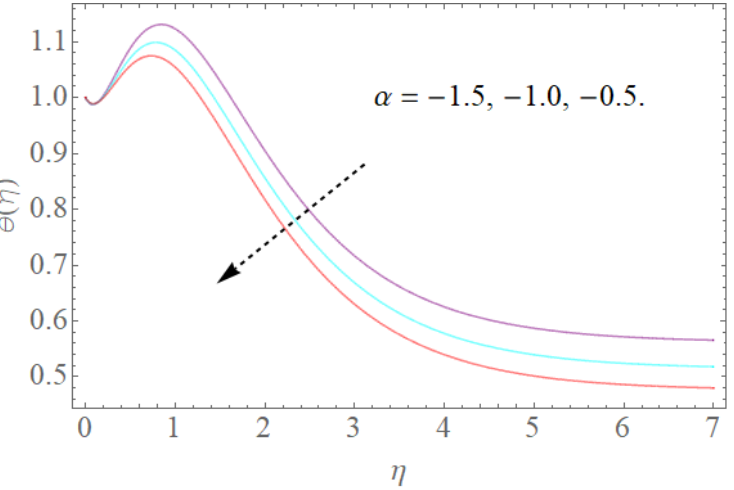
Figure 10. The effect of α on θ ( η ) when N t = 0.2,Pr = 12, N b = 0.5.